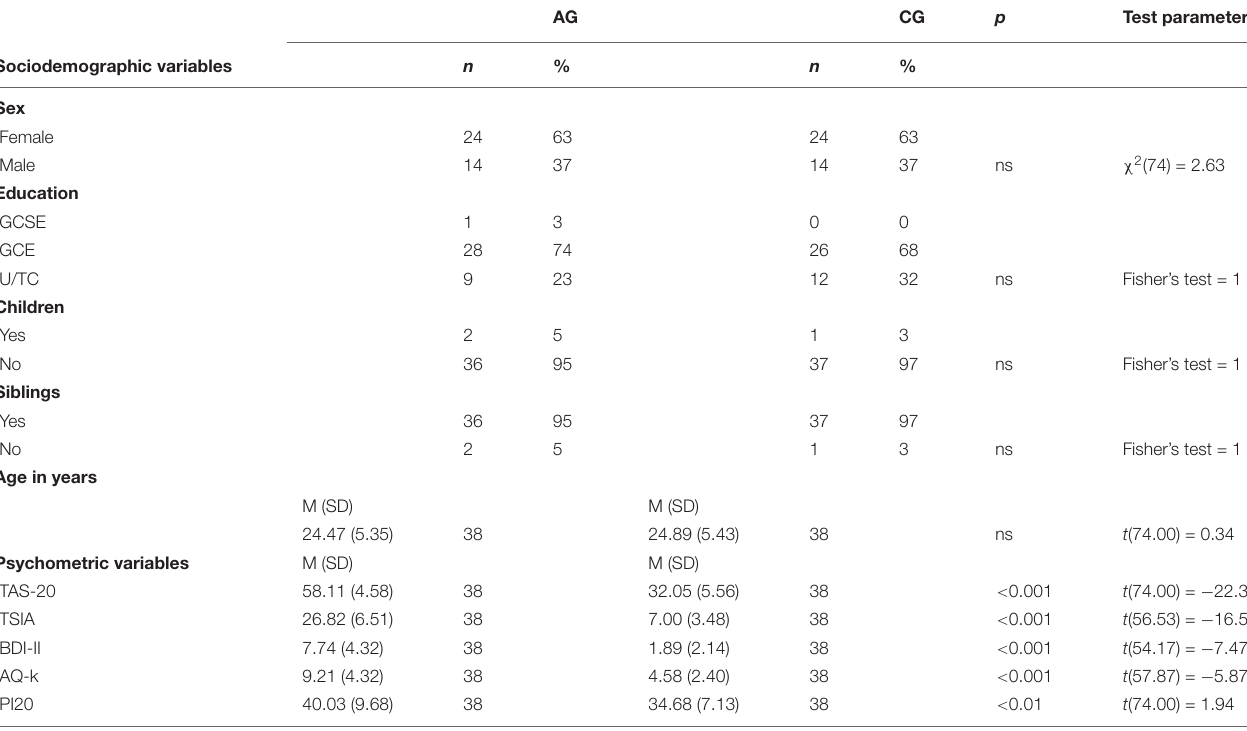
TABLE 1 | Sociodemographic and psychometric characteristics of the sample, Welch df modification was applied for t -tests with unequal variances, for a sample size of less than 5 (education, children, and siblings) the exact Fisher test was used. AG CG p Test